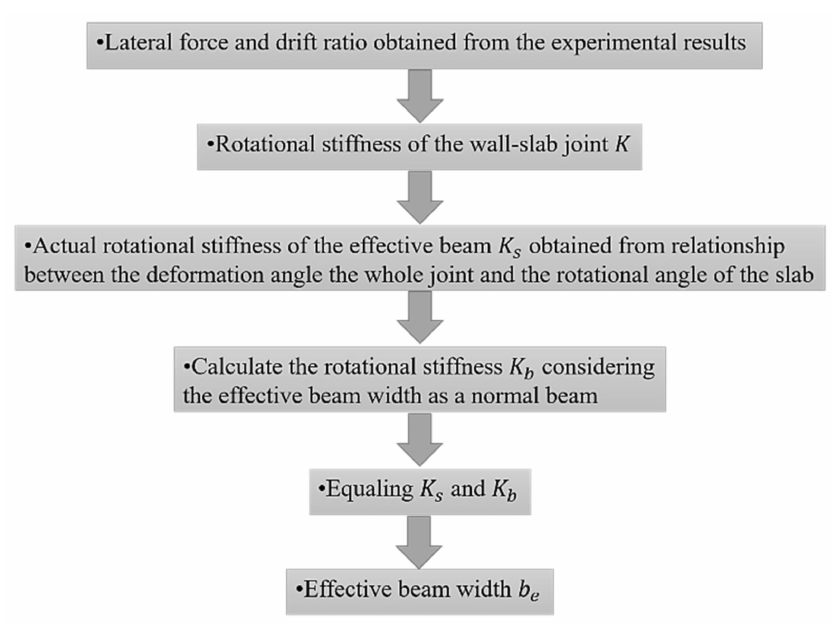
Figure 6. Calculation flow chart for the effective beam width b e